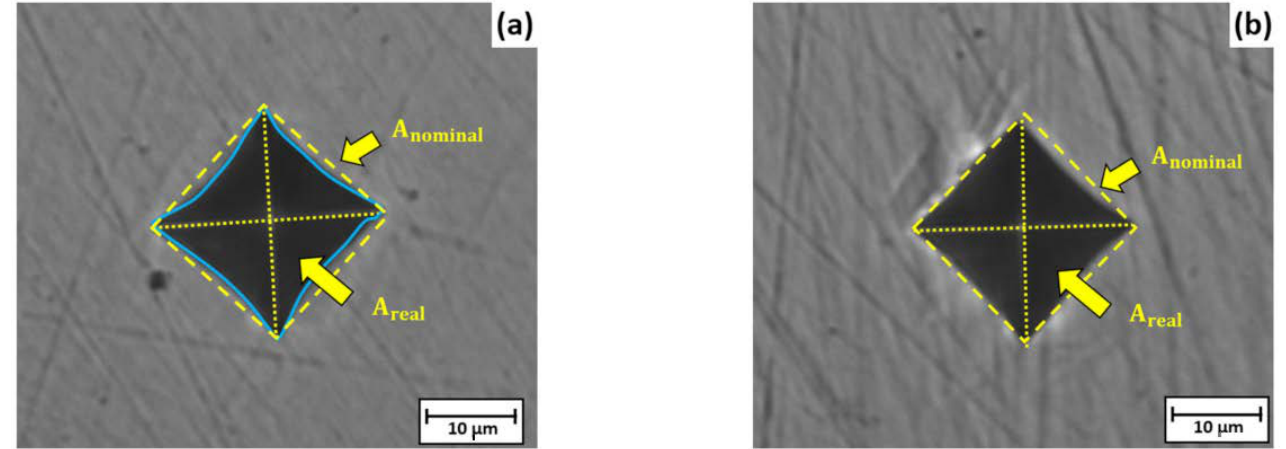
Figure 7. Indentations of ( a ) as-fabricated and ( b ) annealed (case 6) specimens. A nominal is the area of the tip of indenter and A real is the area of indented region.